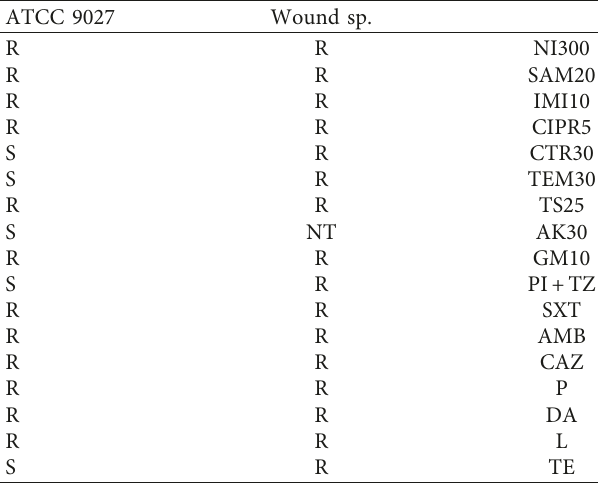
Table 6: Susceptibility of standard strain and wound strain to various antibiotic disks. ATCC 9027 Wound